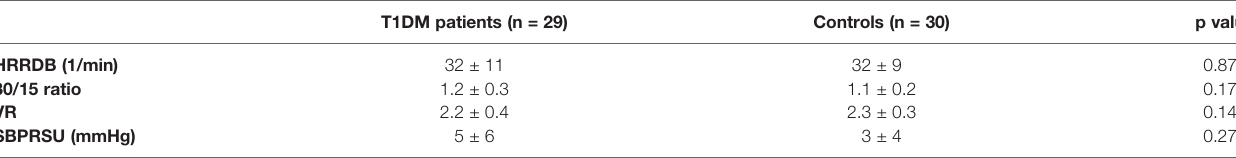
TABLE 4 | Results of the cardiovascular autonomic function tests in T1DM patients and controls.